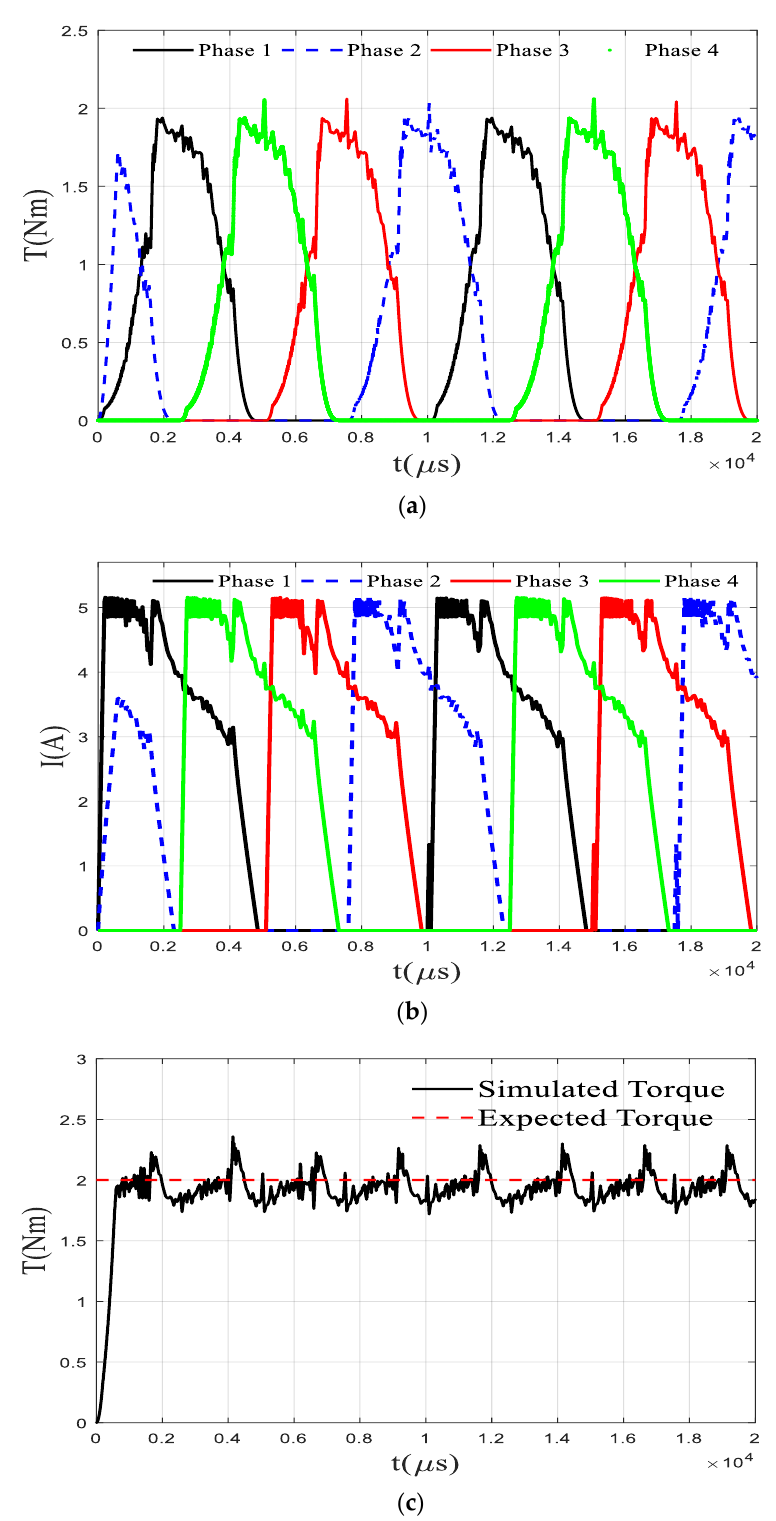
Figure 10. Results under traditional DTC ( a ) Torque ( b ) Current ( c ) Sum of torque.